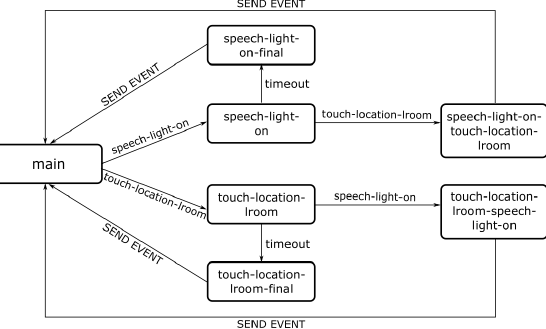
Figure 7. Example of a simple state machine for fusion of two